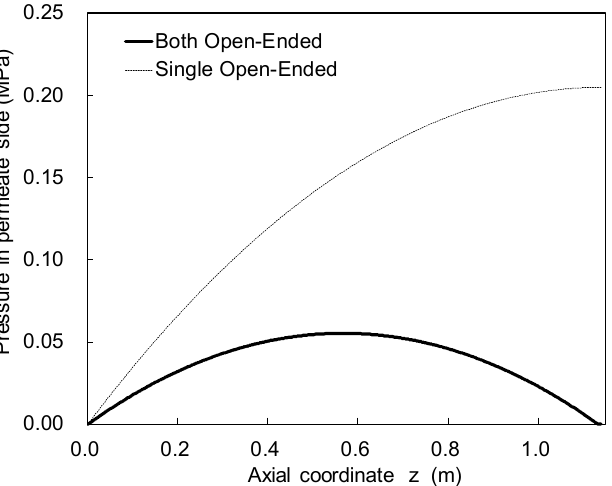
Figure 8. Bore side pressure distribution along the axial direction when using HF with an outer diameter (OD) of 160 µ m; operating pressure was 5.5 MPa; 3.5% NaCl was used as feed.